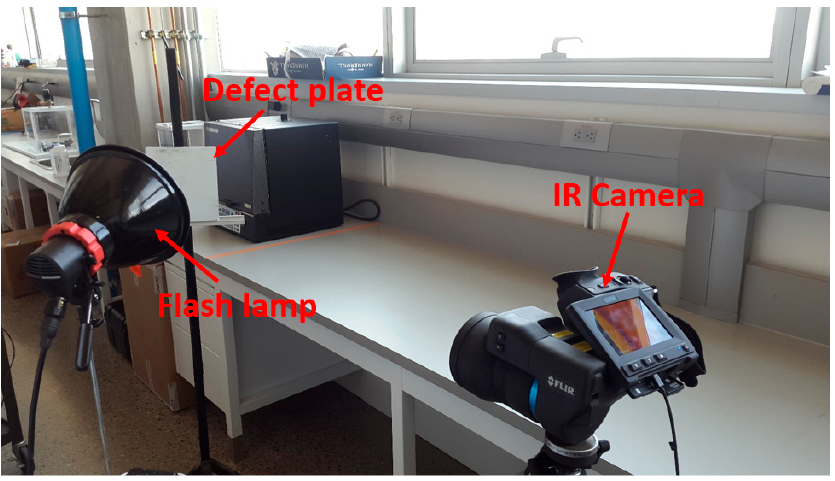
Figure 3. Pulsed thermography experiment.